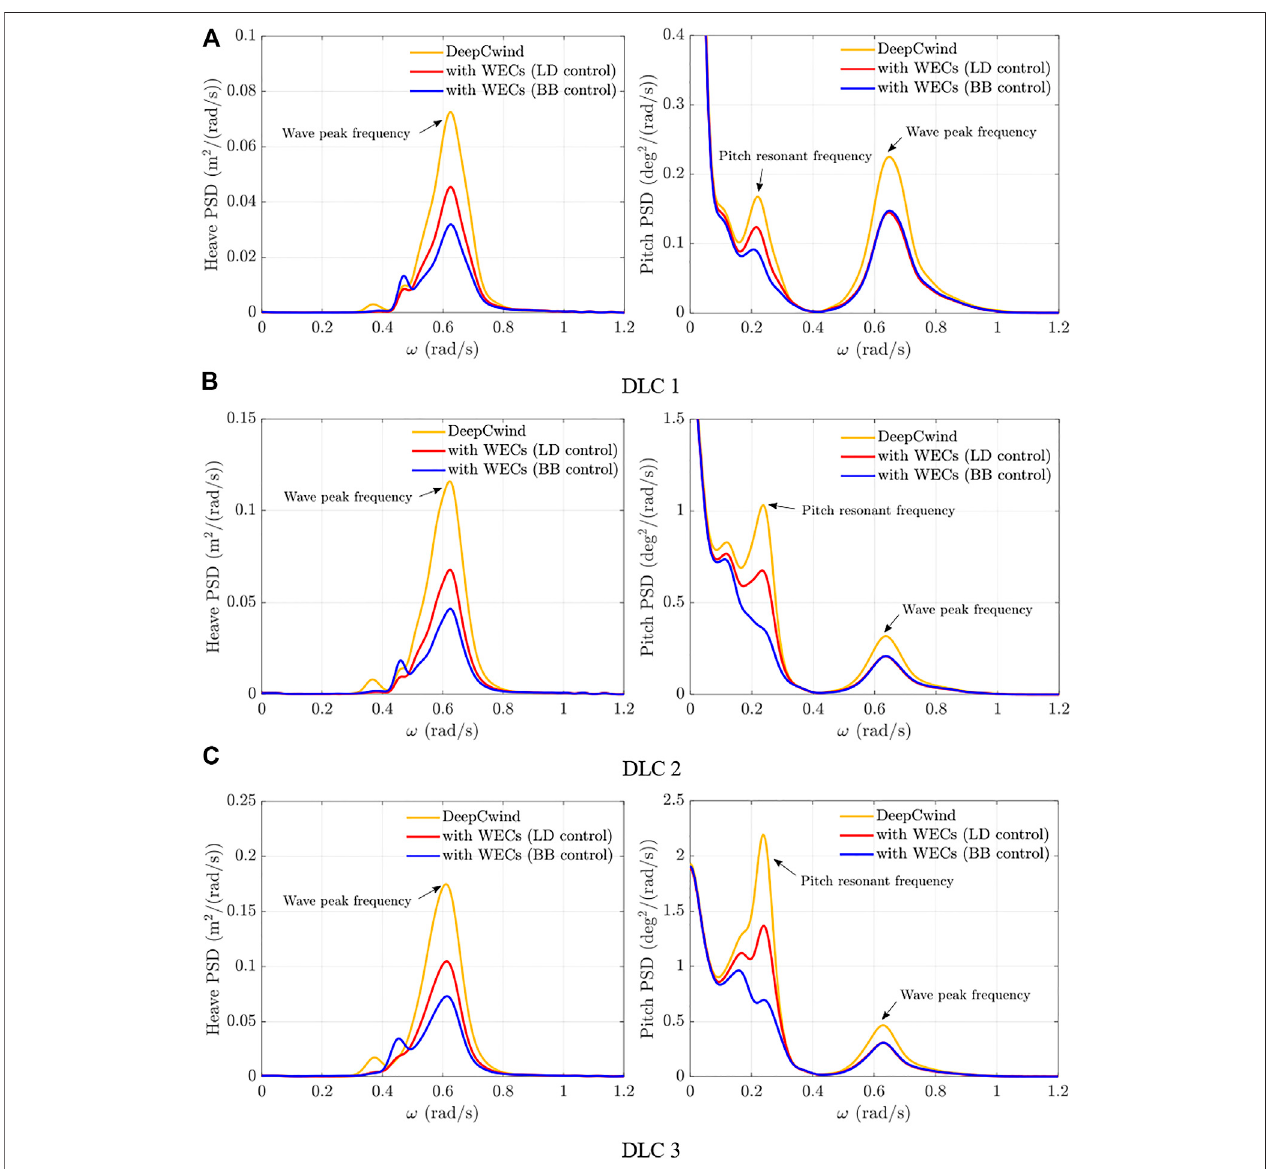
FIGURE 15 | Smoothed power spectra of the platform motions with different PTO control strategies. (A) DLC 1. (B) DLC 2. (C) DLC 3.